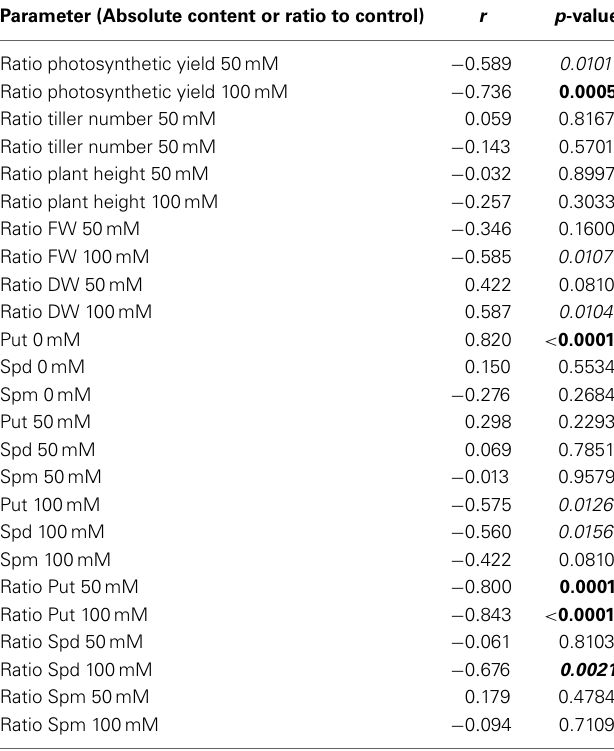
Table 2 | Spearman correlation analysis between the mean sensitivity rank at 100mM NaCl and the ratio of all available growth parameters under stress compared to control conditions, absolute polyamine content in nmol g − 1 DW and ratio of polyamine content under stress in comparison to control